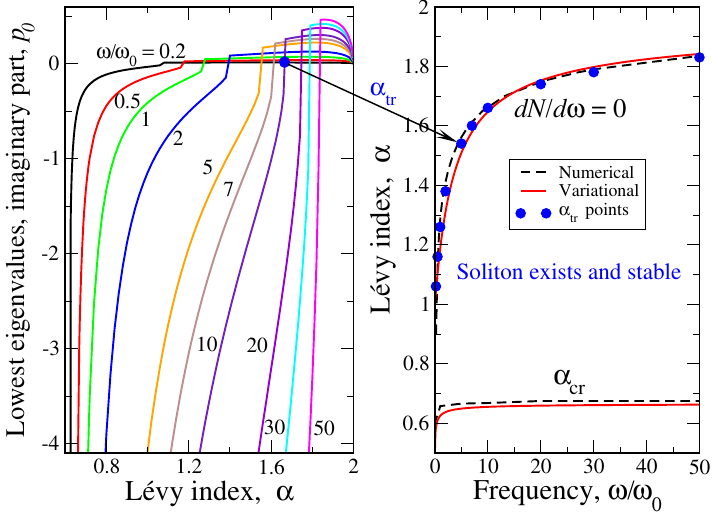
Figure 6. Left panel reports the imaginary part of the lowest eigenvalue p 0 as a function of Lévy index α at ω/ω 0 (figures near curves). For each (cid:31) , at α tr < α < 2 , p 0 > 0 and the soliton is unstable. At different � = the same time, at α cr < α < α tr p 0 < 0 and the soliton is stable. Arrow between left and right panels shows 10 , but this is also valid for all (cid:31) ’s) that the points α 0 , (specifically for (cid:31) tr (�) fall on the the curve dN / d ω = = defining the stability boundary according to VK criterion. The numerical and variational curves for stability 0 ) and soliton existence ( α ( dN / d ω cr (�) ) boundaries in the right panel are shown as the guides for eye to = delineate the range of stable solitons existence in our